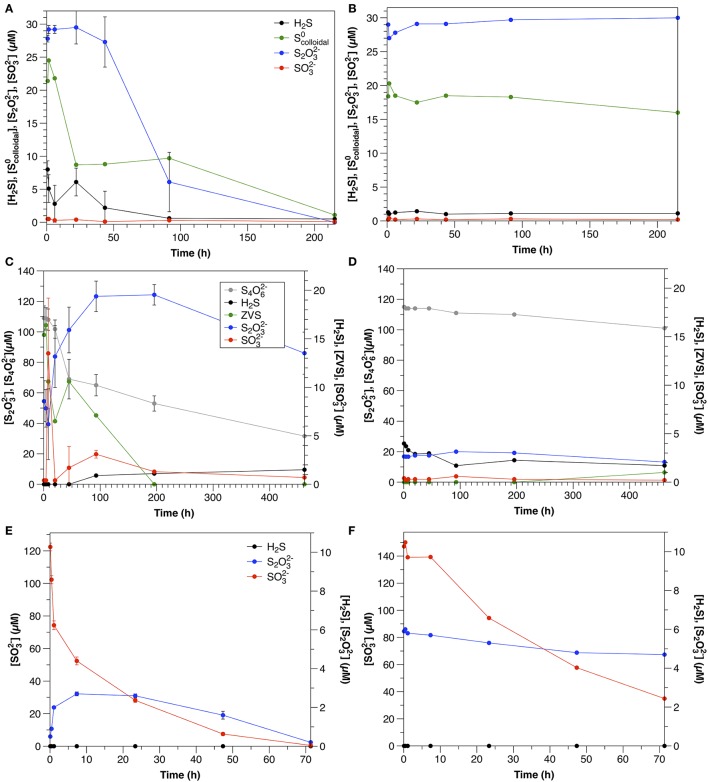
Sulfur dynamics in experiments amended with colloidal sulfur (A = Exp 4A; B = Exp 4B), tetrathionate (A = Exp 6A; B = Exp 6B) and sulfite (A = Exp 7A; B = Exp 7B). Sulfide concentrations in Experiment 7 were below detection (1 μM) at all times. Error bars represent three independent replicates.